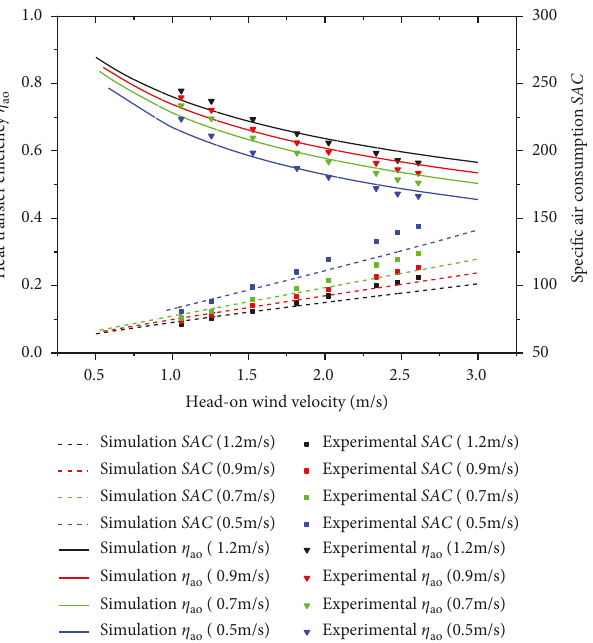
Figure 9: Effects of the head-on wind velocity and water flow velocity to heat transfer